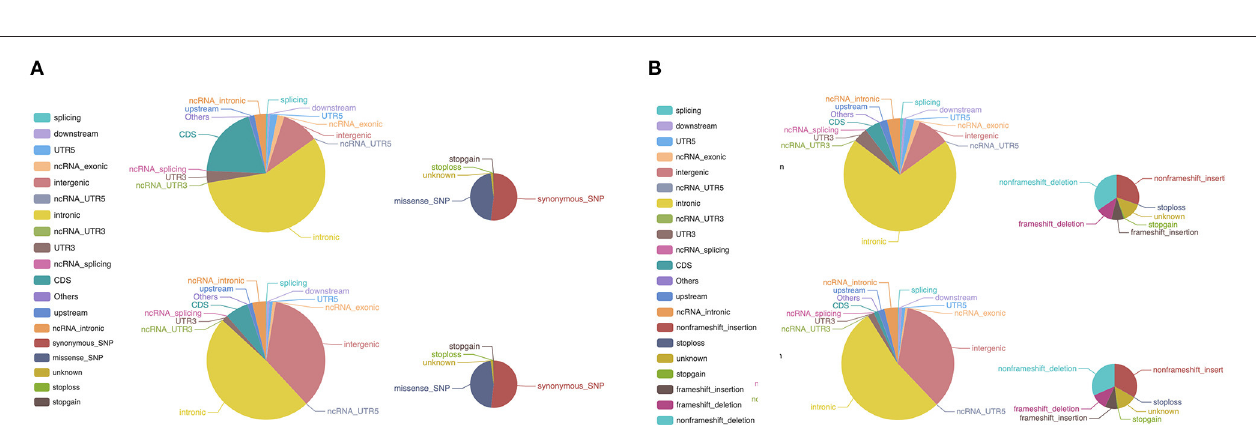
FIGURE 2 | Pathological examination of the suprasellar hypothalamic lesion. H&E staining showing clusters of small neurons intermixed with glia and relatively sparse large neurons (a) . IHC (magnification × 400) showing positive staining for GFAP (b) , P-gp (c) , S-100 (d) , vimentin (e) , and synaptophysin (f) , and partial positive staining for EGFR (g) . Negative staining was seen for neurofilament (h) , SOX-10 (i) , CD99 (j) , CK (k) , and EMA (l) (Scale bar = 100 um). H&E, hematoxylin and eosin; IHC, immunohistochemistry; GFAP, glial fibrillary acidic protein; P-gp, P-glycoprotein; SYN, synaptophysin; EGFR, epidermal growth factor receptor; NF, neurofilament; SOX-10, Sry-related HMg-Box gene 10; CD 99, cluster of differentiation 99; CK, cytokeratins; EMA, epithelial membrane antigen.